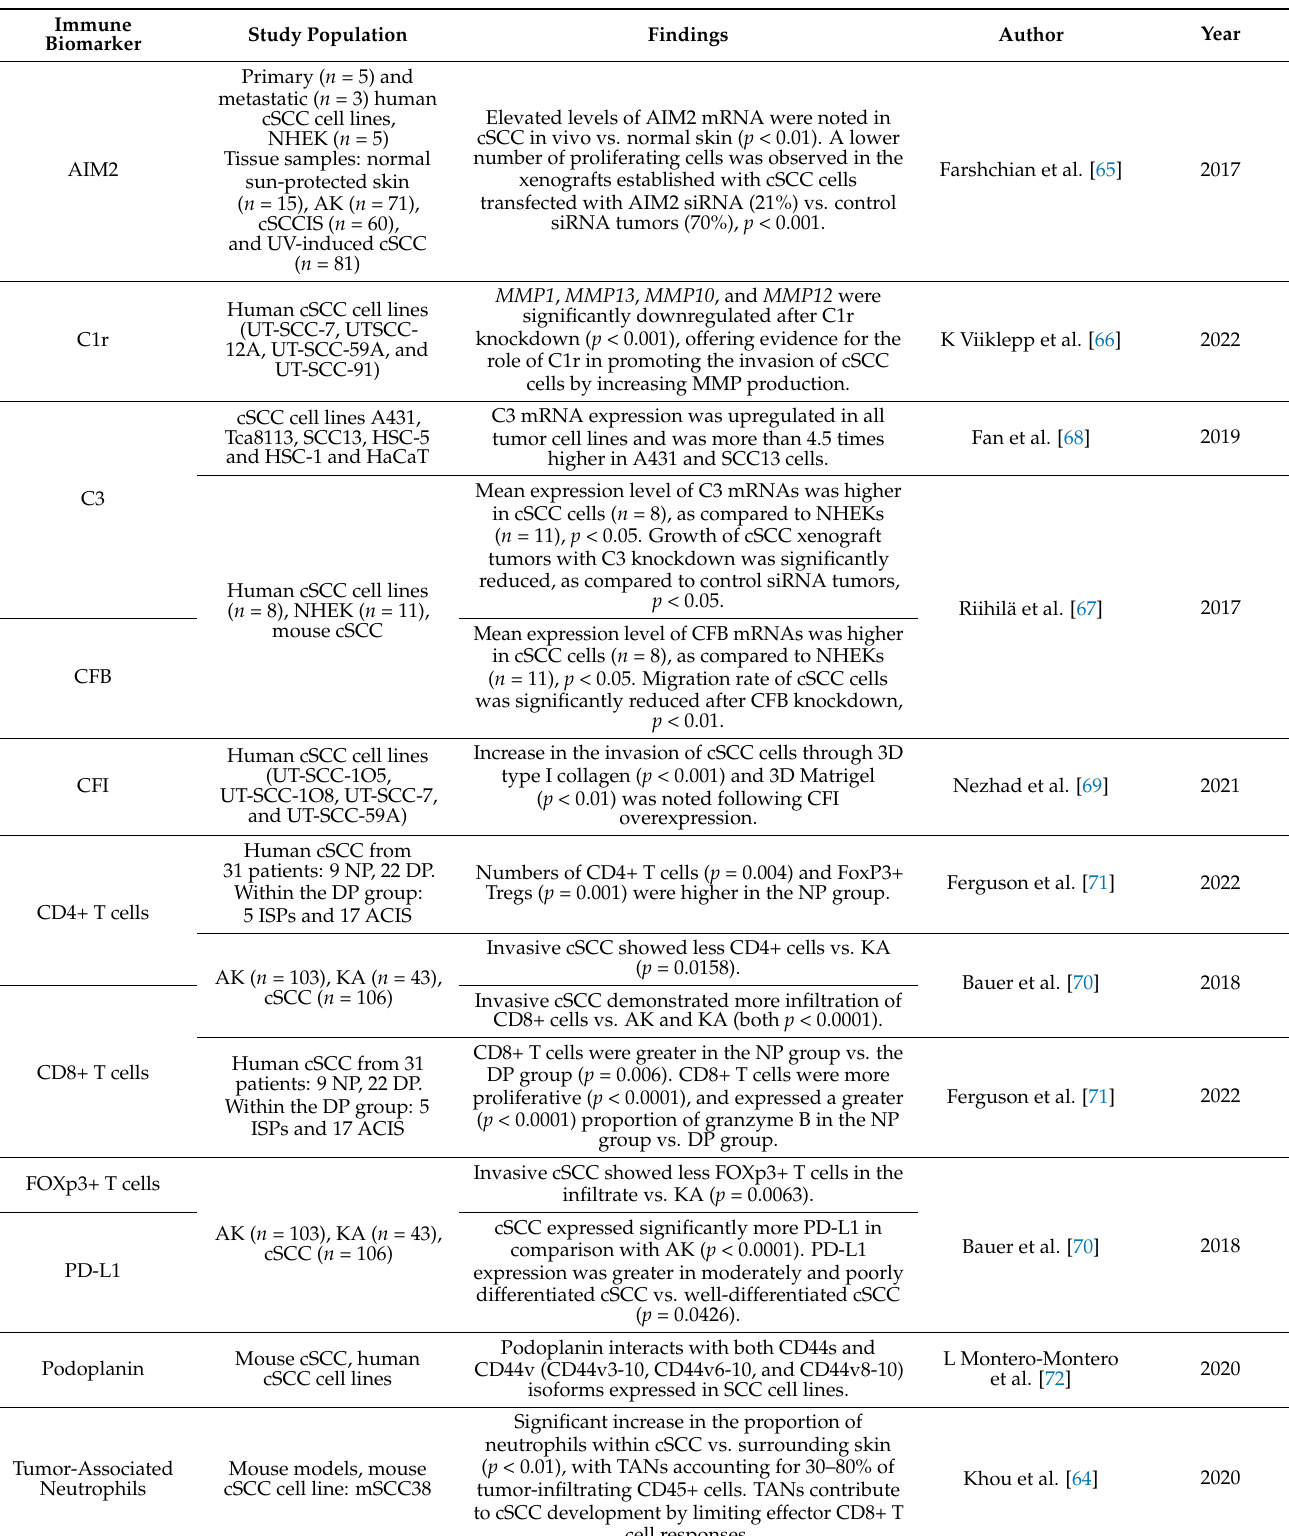
Table 6. Immune alterations associated with cSCC